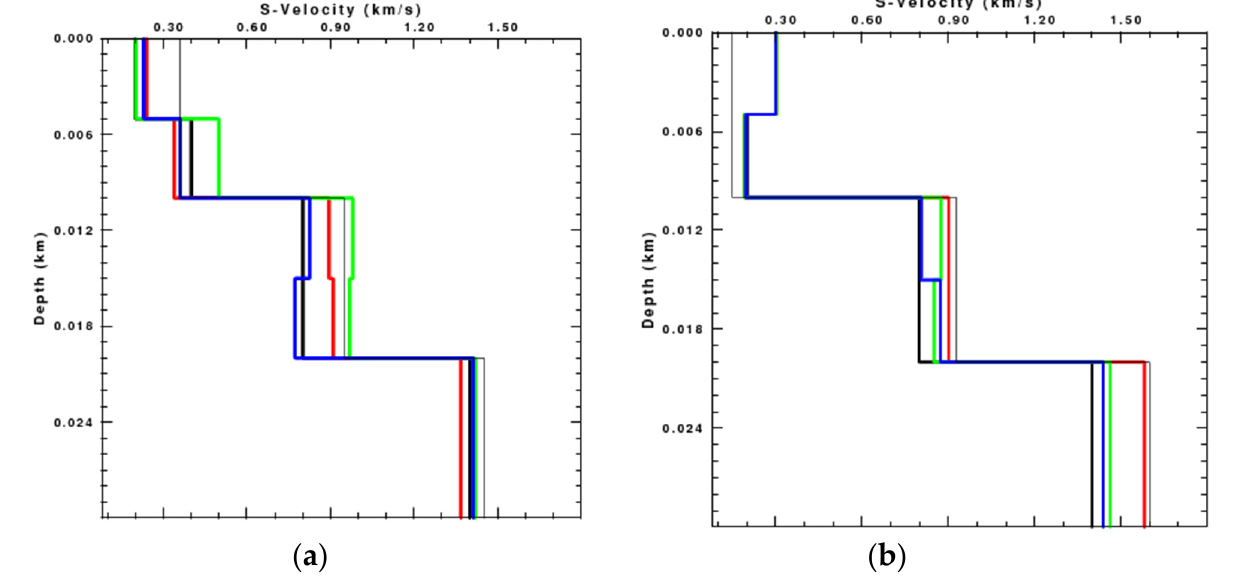
Figure 7. Results of the Rayleigh wave inversion using the radial (red line), vertical (green line), and